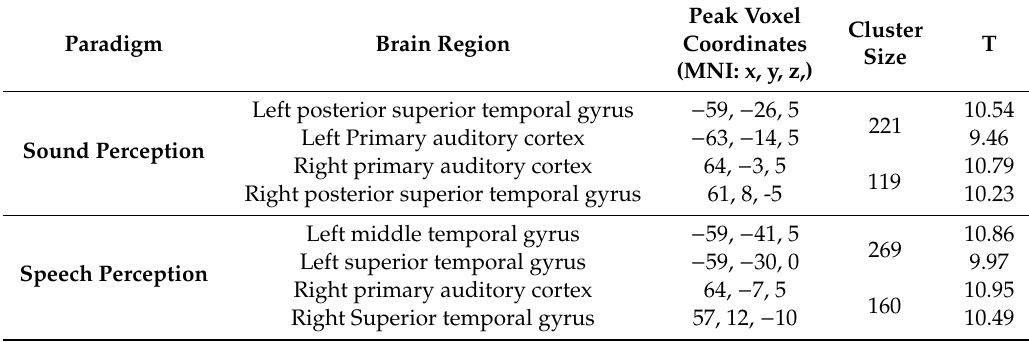
Table A2. Peak voxel activity in the auditory perception paradigm at recovery (9-months post-injury). Paradigm Brain Region